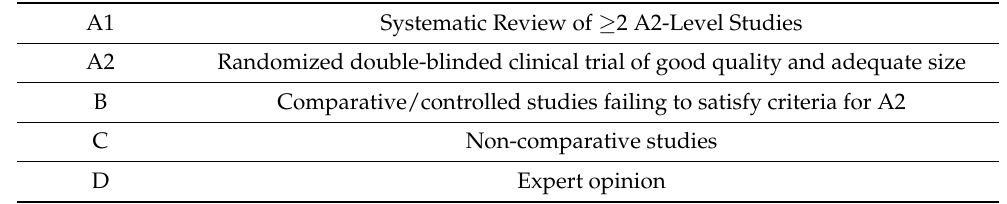
Table 1. Level of Evidence.